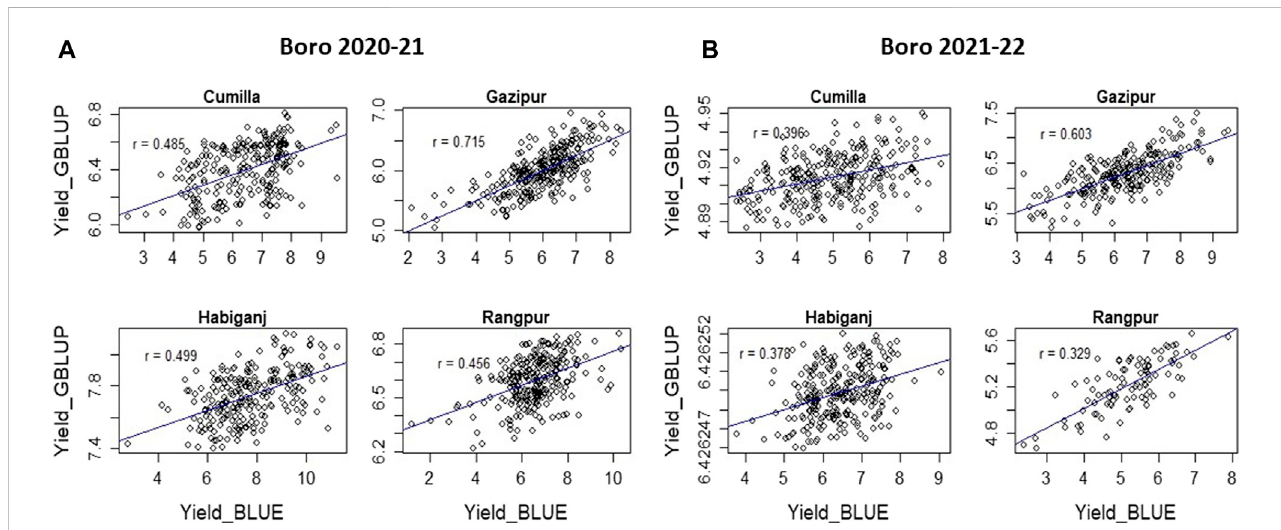
FIGURE 3 Accuracy of genomic prediction estimated from OYT trial conducted with 799 lines during Boro 2020 – 21 (A) and OYT trial conducted with 548 lines during Boro 2021 – 22 (B) at four locations in Bangladesh.